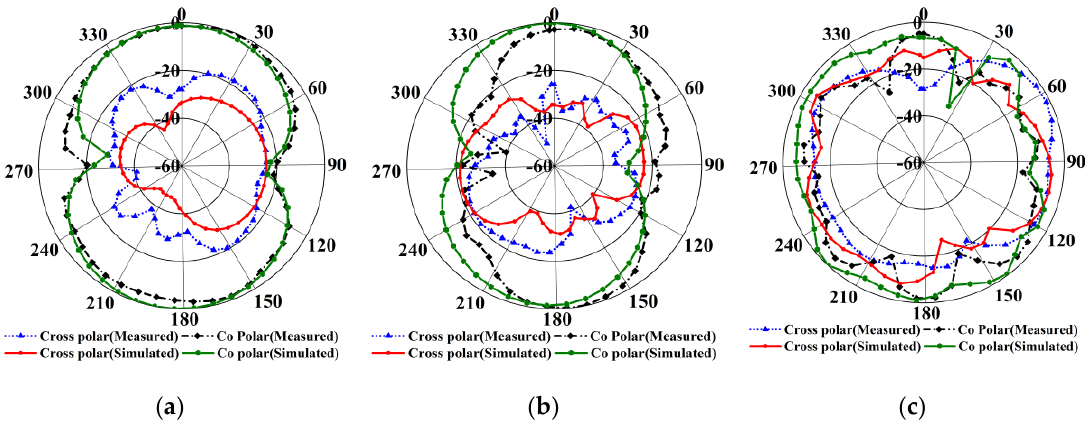
Figure 9. Simulated and measured 2D radiation pattern of E plane (φ = 0) of the proposed antenna at: ( a ) 3.50 GHz; ( b ) 5.50 GHz; (c ) 10.00 GHz.